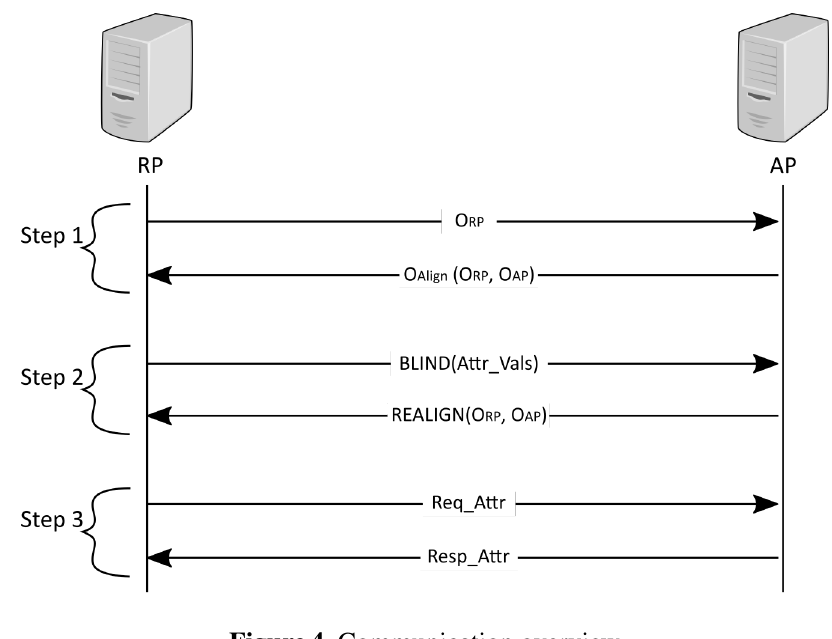
Figure 4. Communication